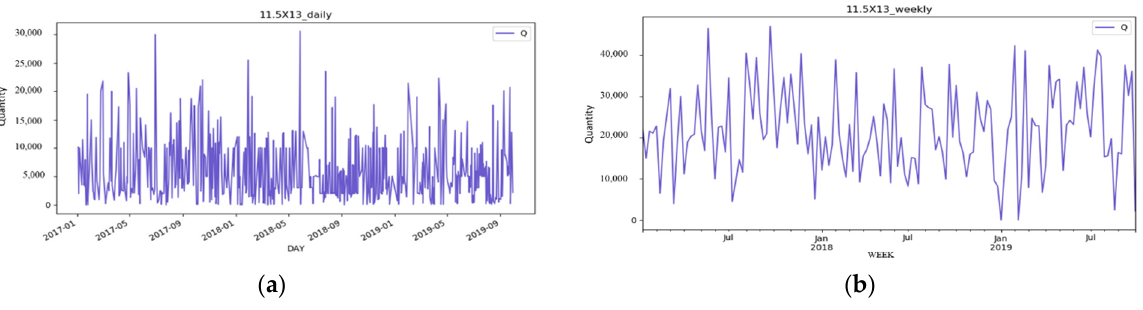
Figure 2. Timeline conversion of the difference graph. ( a ) BGA 11.5X13 timeline is daily; ( b ) BGA 11.5X13 timeline is one week.